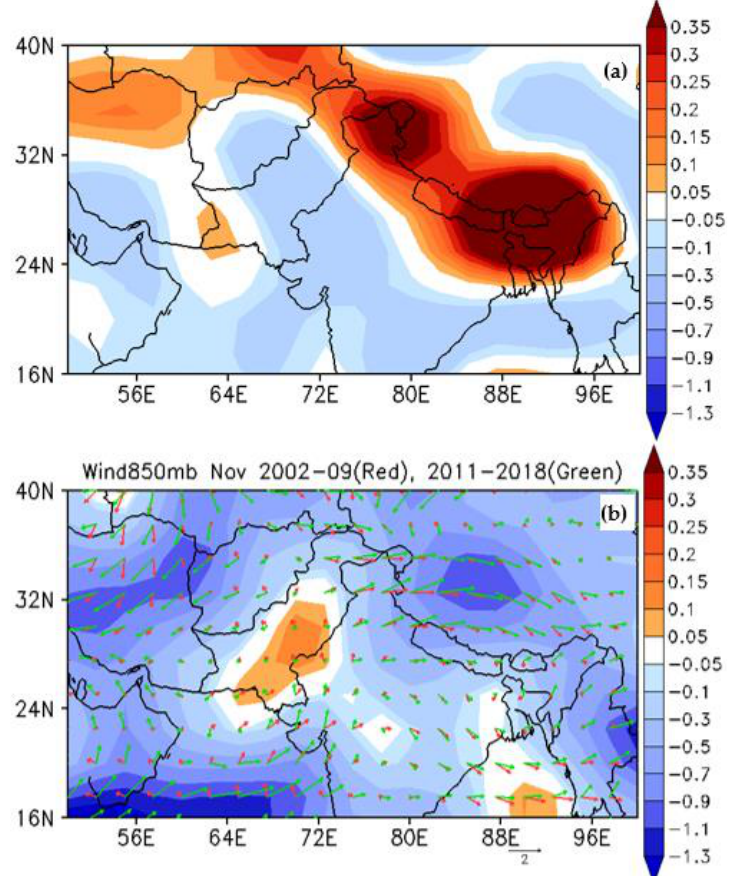
Figure 6. November ( a ) Vertical velocity (Omega at 900 mb) ( b ) Winds for two periods and differ- ence in the magnitude of 2002 – 2009 to 2011 –